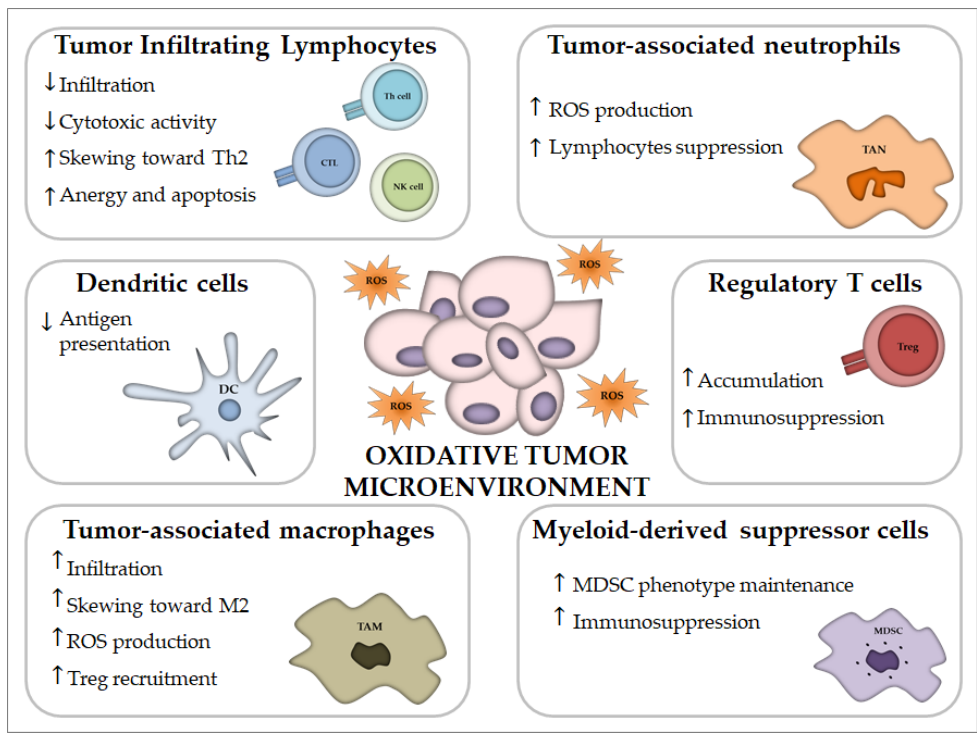
Figure 2. Impact of oxidative stress on immune cells of the tumor microenvironment. Oxidative stress in the tumor microenvironment promote immune suppression. It can reduce the infiltration of lymphocytes and favor the recruitment and accumulation of regulatory T cells and M2 tumor-associated macrophages. Antigen presentation by dendritic cells results impaired and tumor infiltrating lymphocytes are dysfunctional. Myeloid-derived suppressor cells and tumor-associated neutrophils inhibit lymphocytes functions through ROS production.